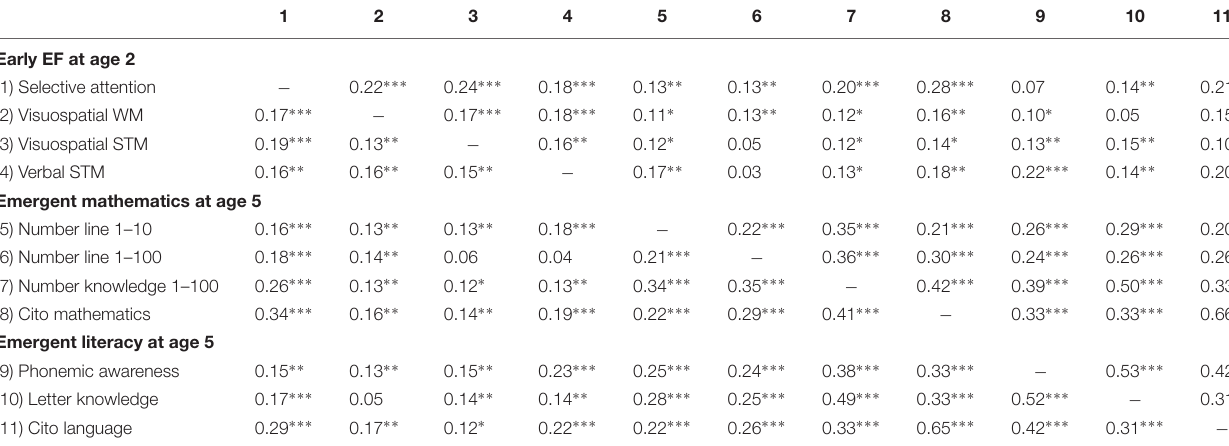
TABLE 2 | Zero-order correlations for all